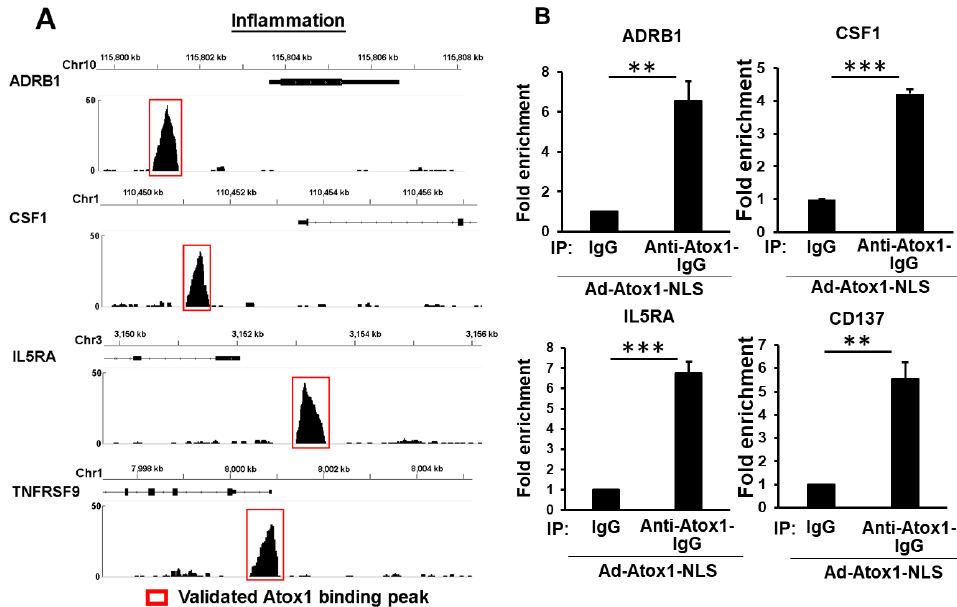
Figure 6. Validation of Atox1 binding peaks. ( A ). Representative tracks from ChIP-Seq results show the locations of Atox1 binding peaks proximal to the TSS of Atox1 targeted genes. Those peaks in red box were validated in ( B ). ( B ). HUVEC cells were transfected with Atox1-NLS for 48 h and sub- ject to ChIP using monoclonal Anti-Atox1 Ab and mouse IgG. The enrichment of Atox1 binding peaks were determined by qPCR (n = 3). *** p < 0.001, ** p < 0.01. 3.6. CD137, IL5RA, and CSF1 as New Atox1 Targets to Regulate Inflammation and ROS Production in ECs: Both RNA-Seq and ChIP-Seq analysis identified CD137 (TNFRSF9), IL5RA, and CSF1 as new direct targets of Atox1 which regulate inflammatory responses. To determine the functional significance of Atox1-NLS-induced CD137, IL5RA,